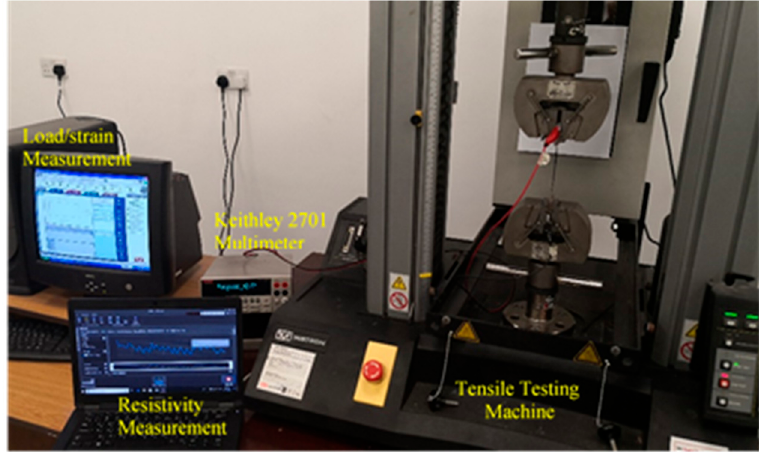
Figure A1. Experimental setup.